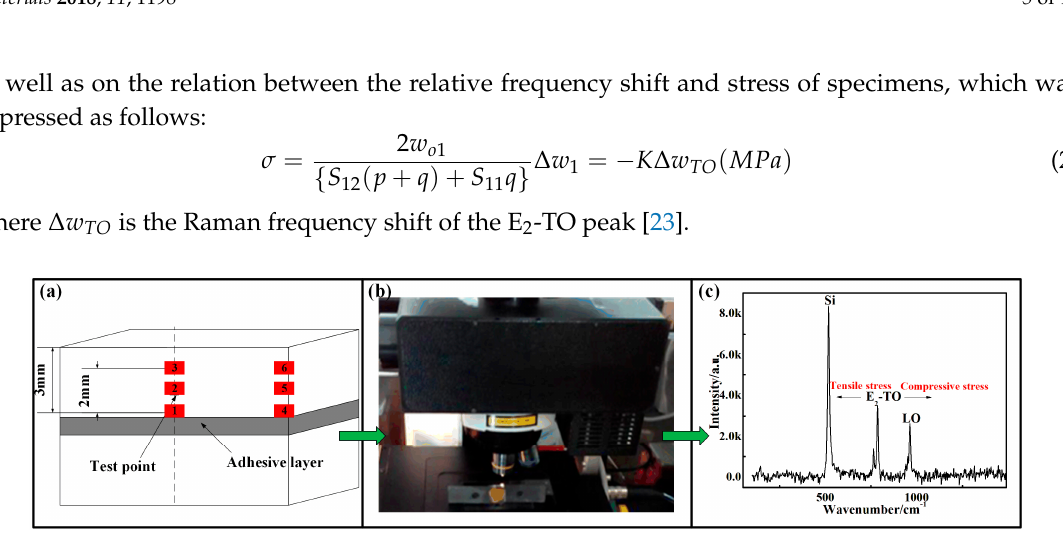
Figure 6. Mesh detail, test points and cohesive elements at the overlap for the L o = 10 mm adhesively bonded layer.